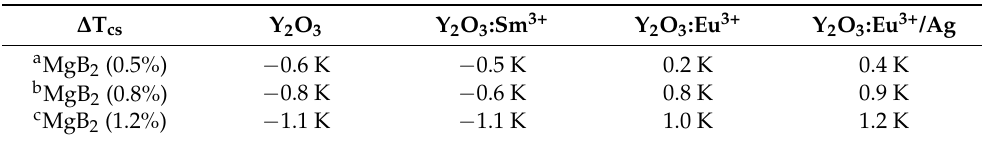
Table 1. ∆ T cs for a MgB 2 + 0.5% x , b MgB 2 + 0.8% x and c MgB 2 + 1.2% x ( x = Y 2 O 3 , Y 2 O 3 :Sm 3+